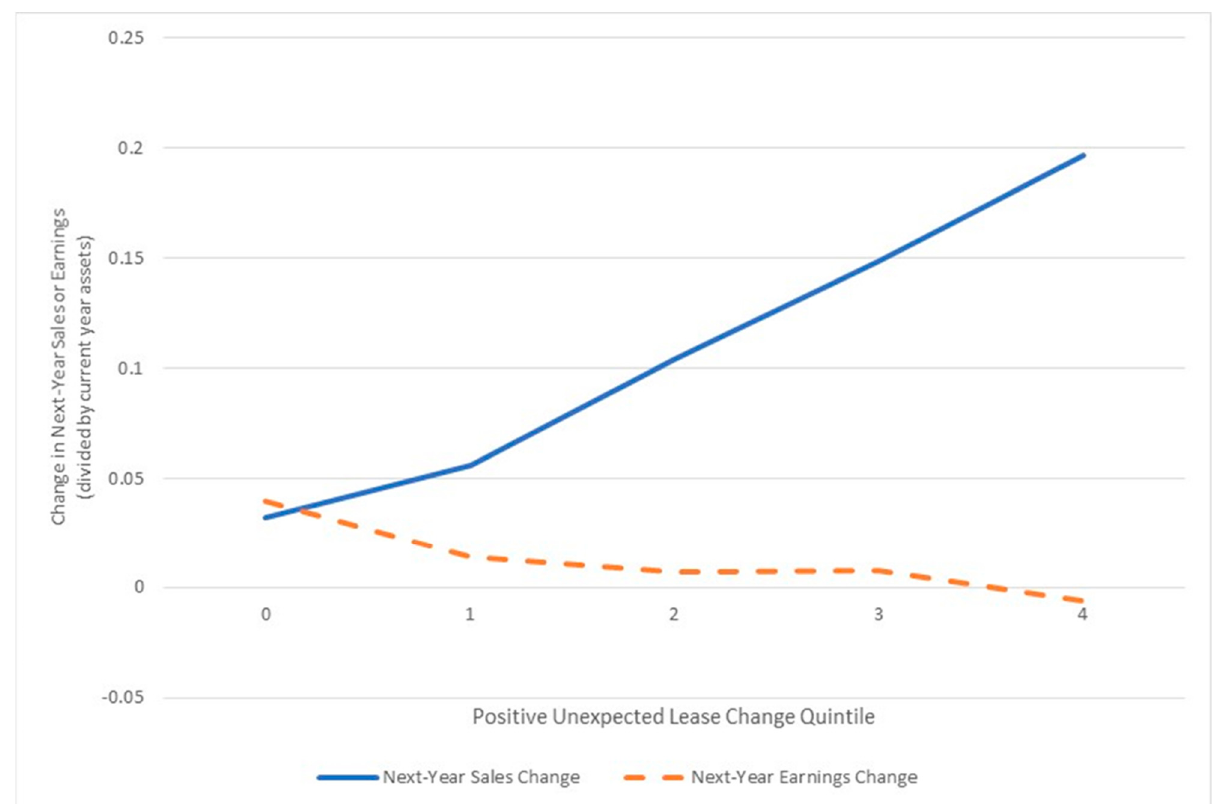
Figure 2. Next-year Changes in Sales and Earnings by Positive Unexpected Lease Change Quintile.